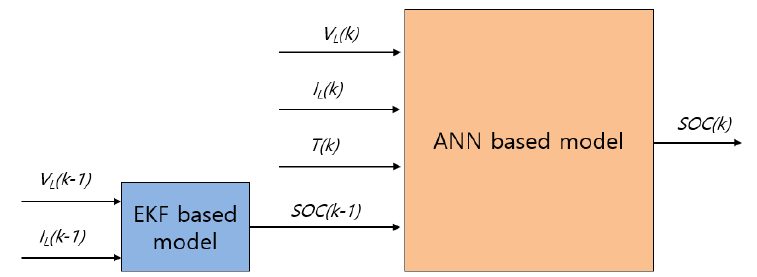
Figure 11. Configuration of the SOC estimation method combining the EKF with ANN.